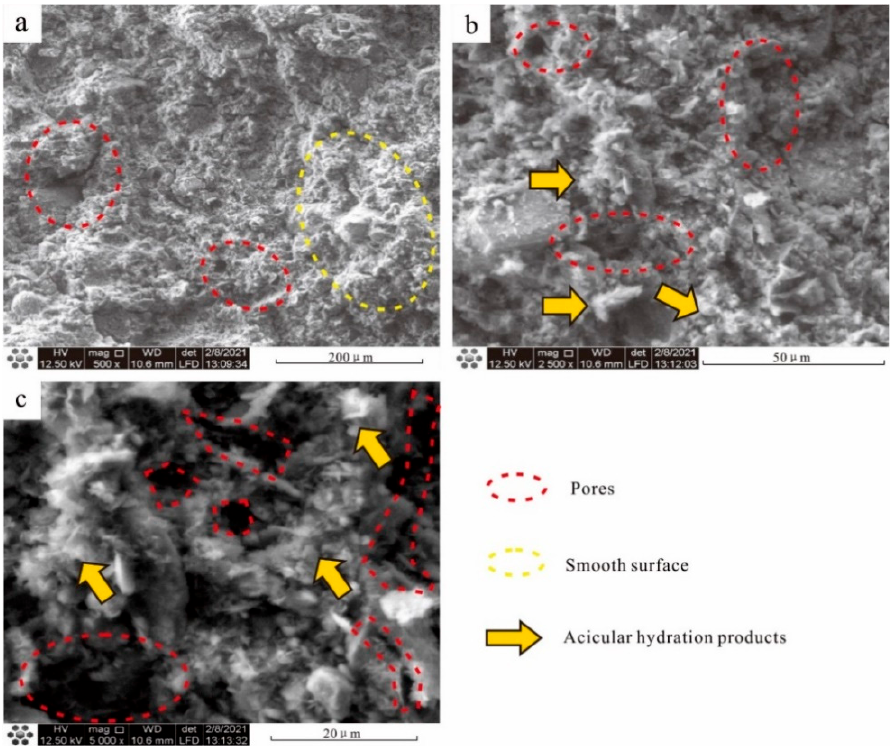
Figure 16. Microstructure of conventional cement solidified soil.